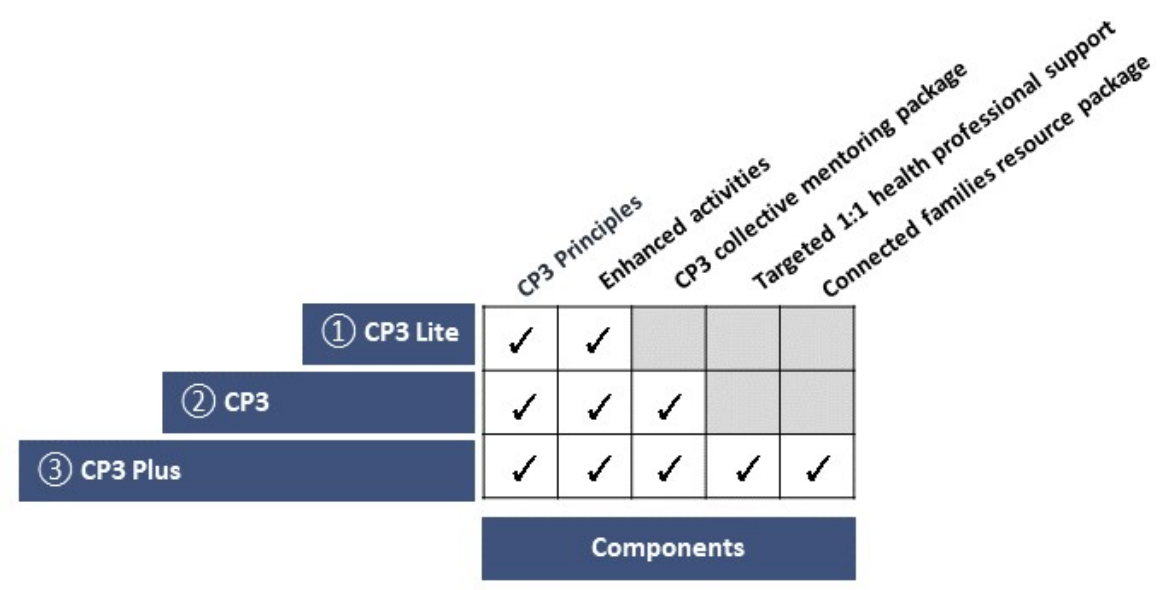
CP3 Lite is the minimal viable product of CP3 ( α -build).